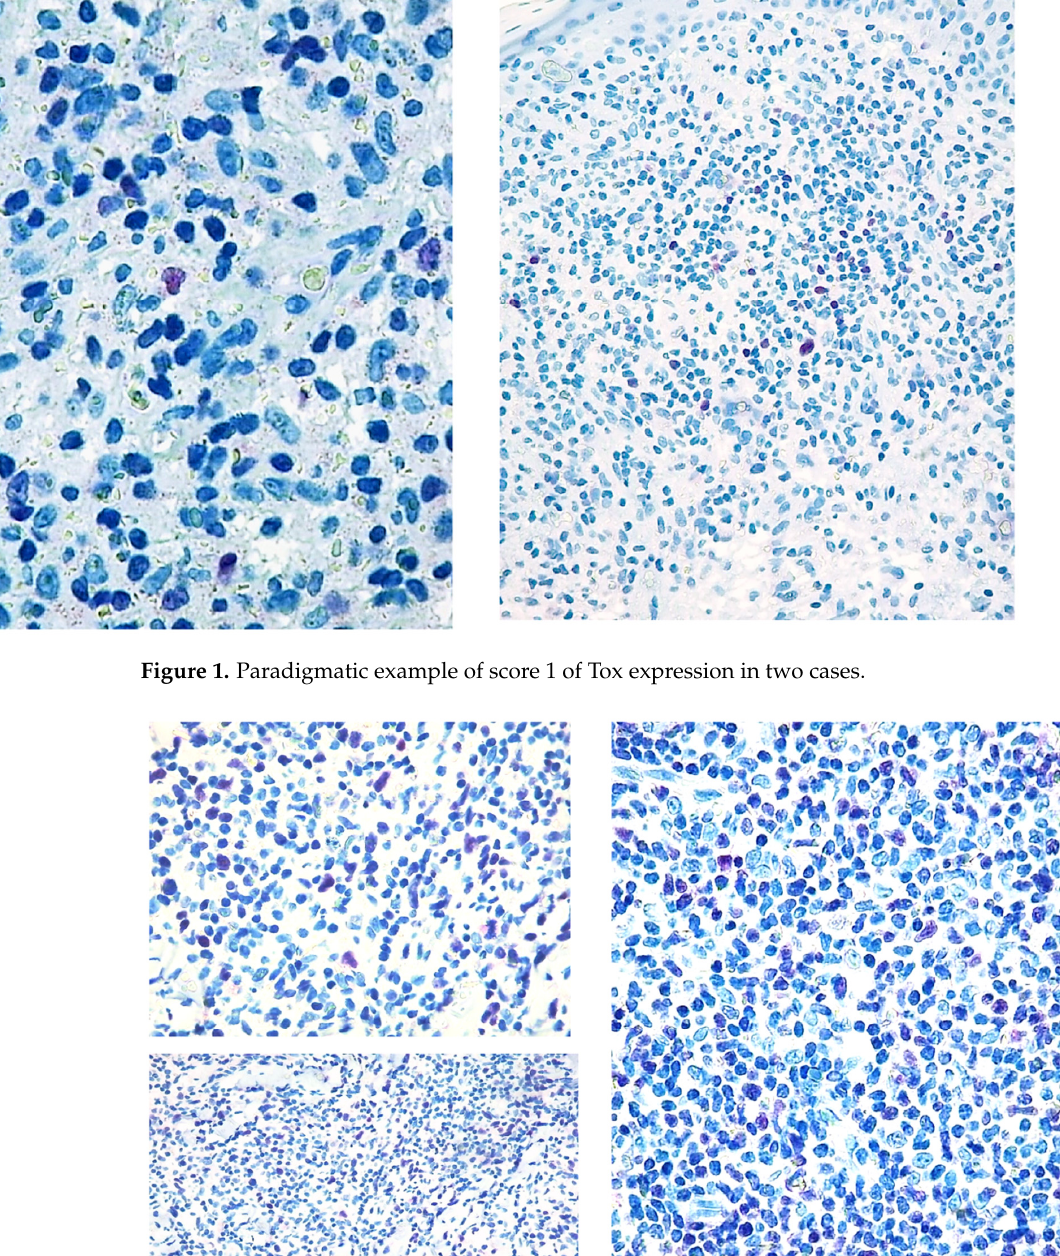
Figure 2. Paradigmatic example of score 2 of Tox expression in different cases.